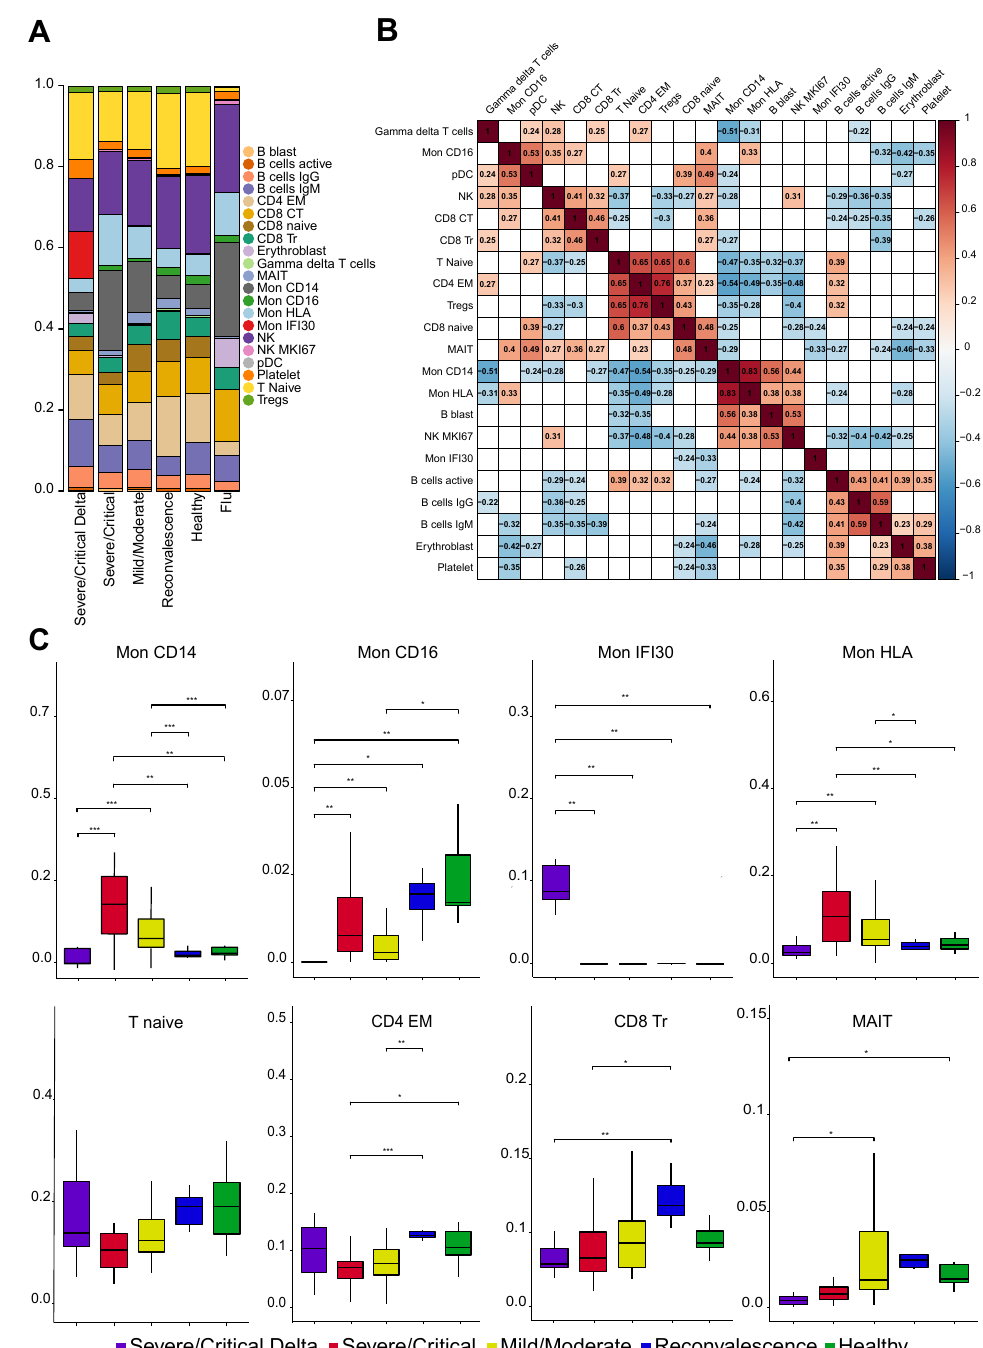
Figure 2. ( A ) Stacked bar plot with the average fraction of cell subtypes across samples. ( B ) Pearson correlation heatmap of the cell fraction for each subtype across samples. Statistically not significant ( p -value > 0.05 according to cor.test in R) elements are blank. ( C ) Boxplot with the fraction of cell subtypes in each sample. *, **, *** means significant changes calculated with Wilcoxon rank-sum and shown as